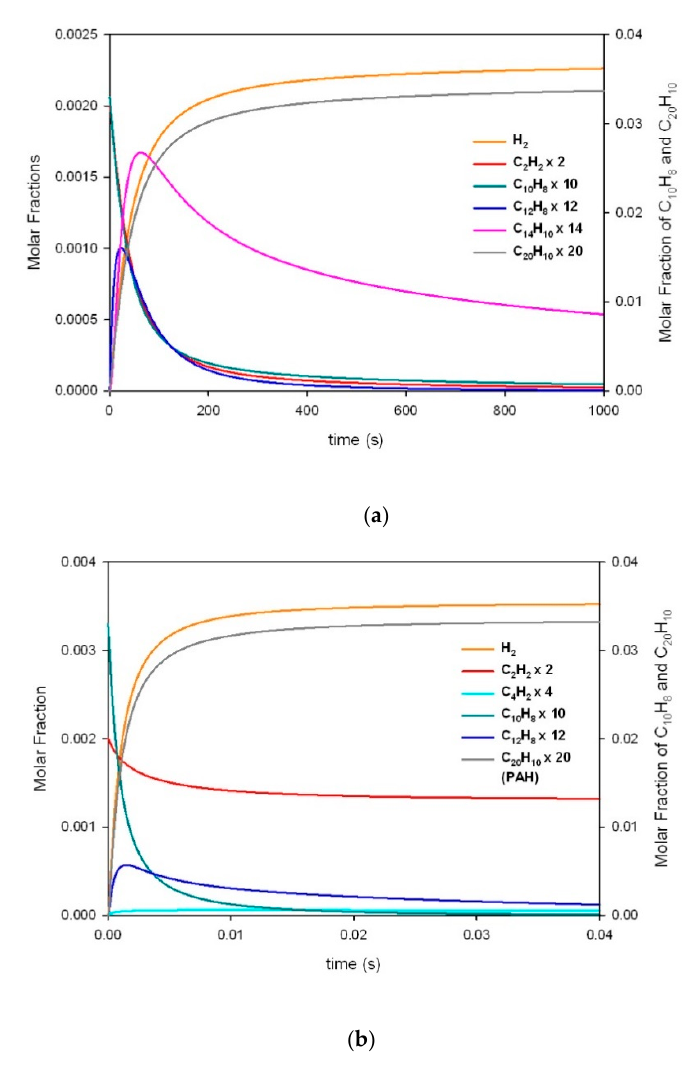
Figure 6. Reaction of naphthalene and acetylene. ( a ) 1200 K; ( b ) 1900 K.